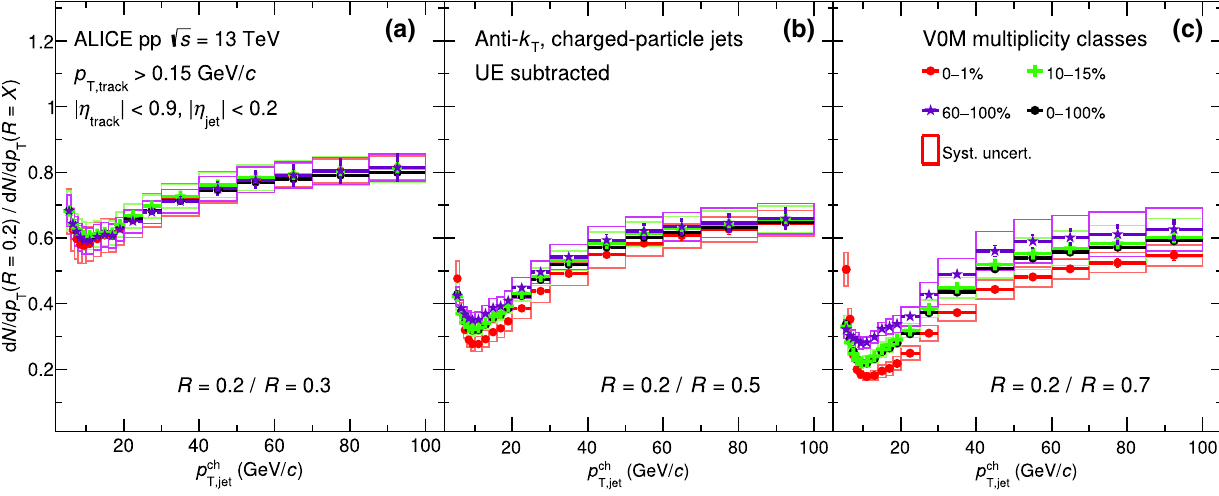
uncertainties are shown as vertical error bars and boxes around the data points, respectively. Results for other radii can be found in